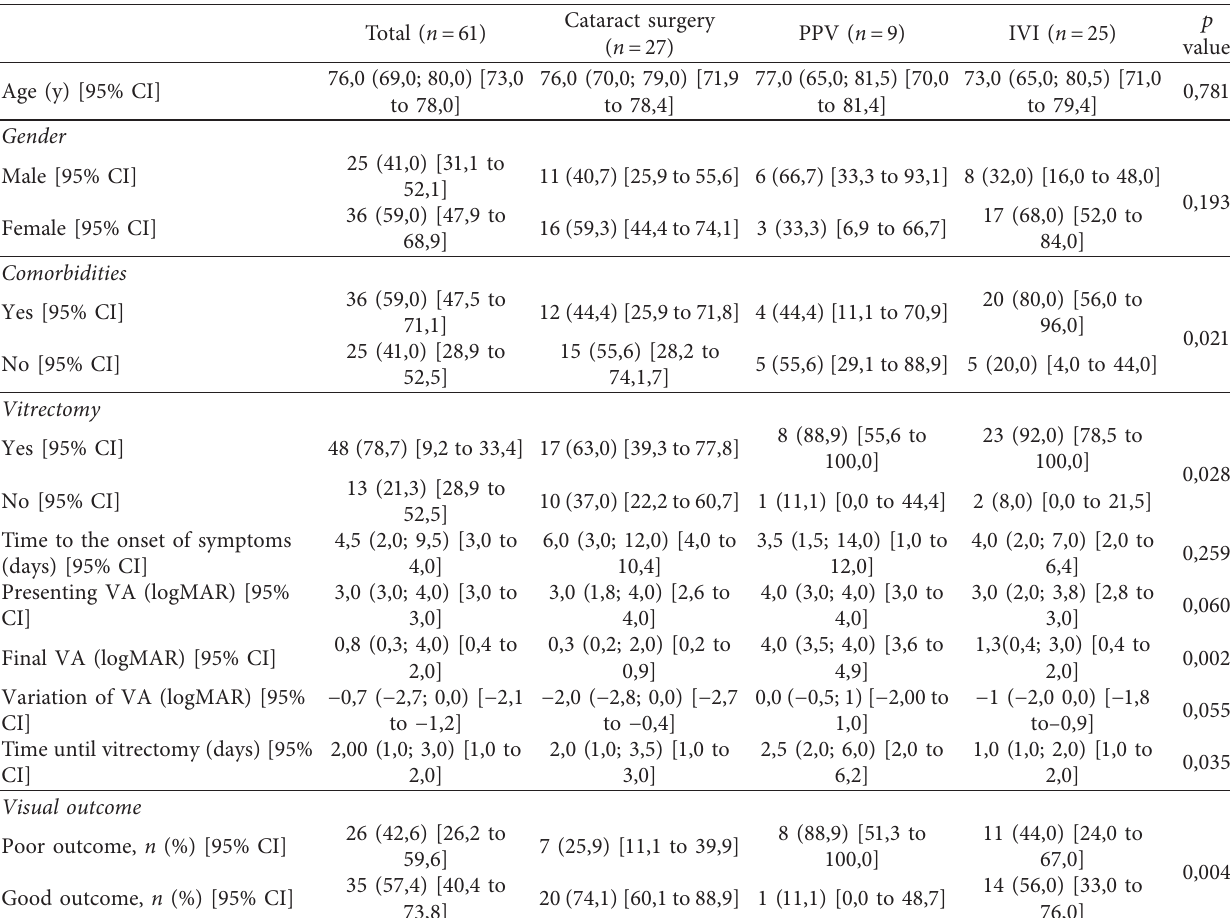
Values are displayed as median (IQR) for continuous variables and number (%) for categorical variables. Comparisons were made with the chi-squared test and Fisherexact test for dichotomous data.For continuous variable, nonparametric Kruskal–Wallistest was used. The level of statisticalsignificance was set at p < . 05. Poor outcome was classified as VA worse than or equal than counting fingers (CF) and good outcome classified as VA better than CF. PPV � pars plana vitrectomy; IV � intravitreal injection; VA � visual acuity; logMAR � logarithm of the minimal angle of resolution. Table 2: Variable comparison and analysis of presumed endophthalmitis cases ( n � 61) after cataract surgery and pars plana vitrectomy (PPV) in Centro Hospitalar Universit´ario de São João.